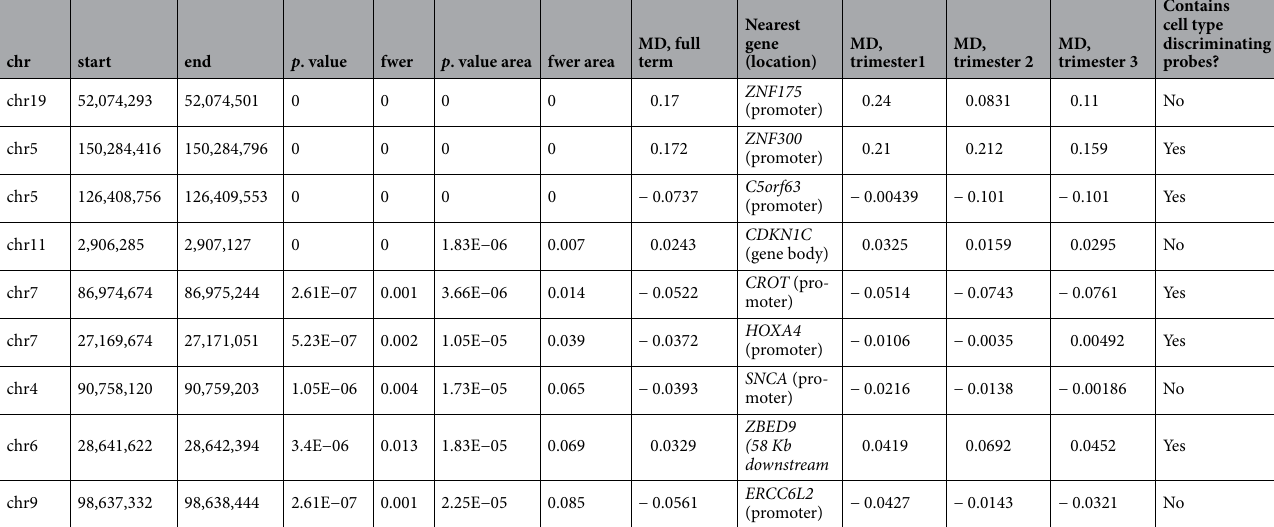
Table 4. Persistence of genome-wide significant differentially methylated regions from full term analysis across the gestational period. Statistics generated from bumphunter() 64 function in minfi package 57 .